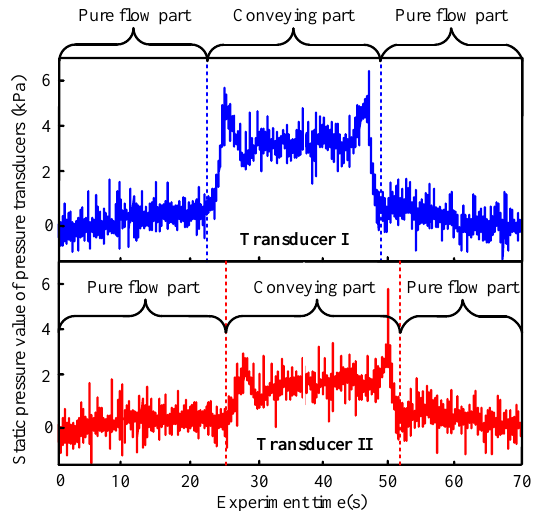
Figure 6. Pressure signal in horizontal pneumatic conveying pipe.